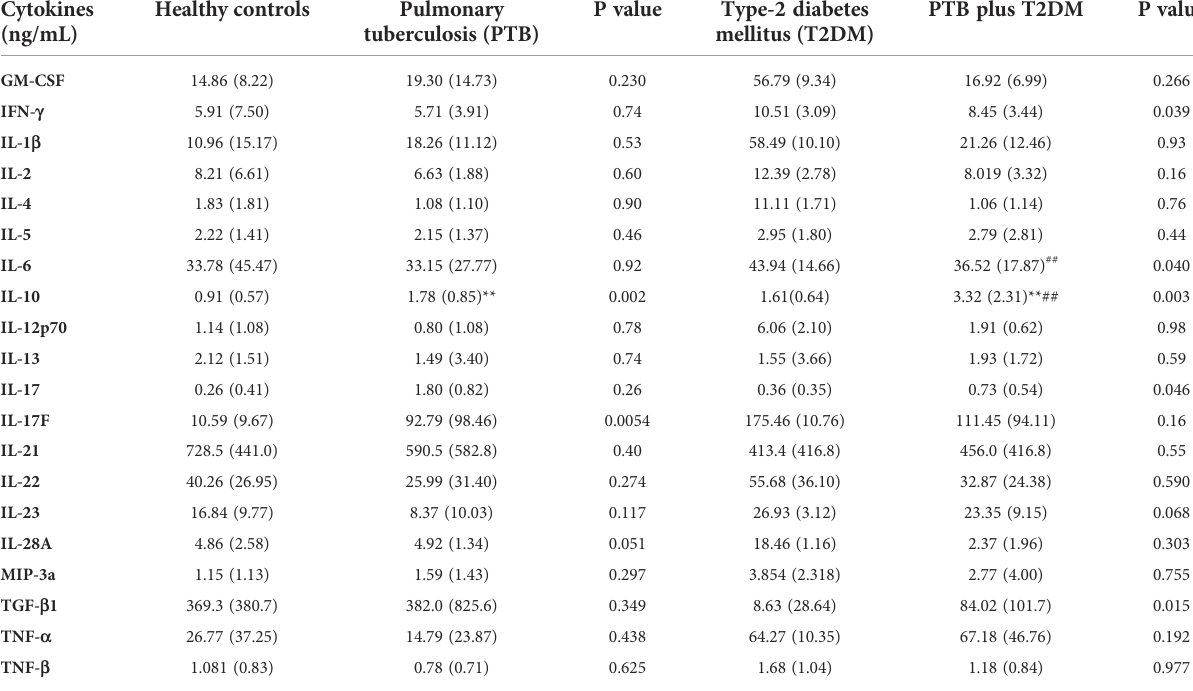
TABLE 2 Immunity and in fl ammation characteristics of study objects in four groups